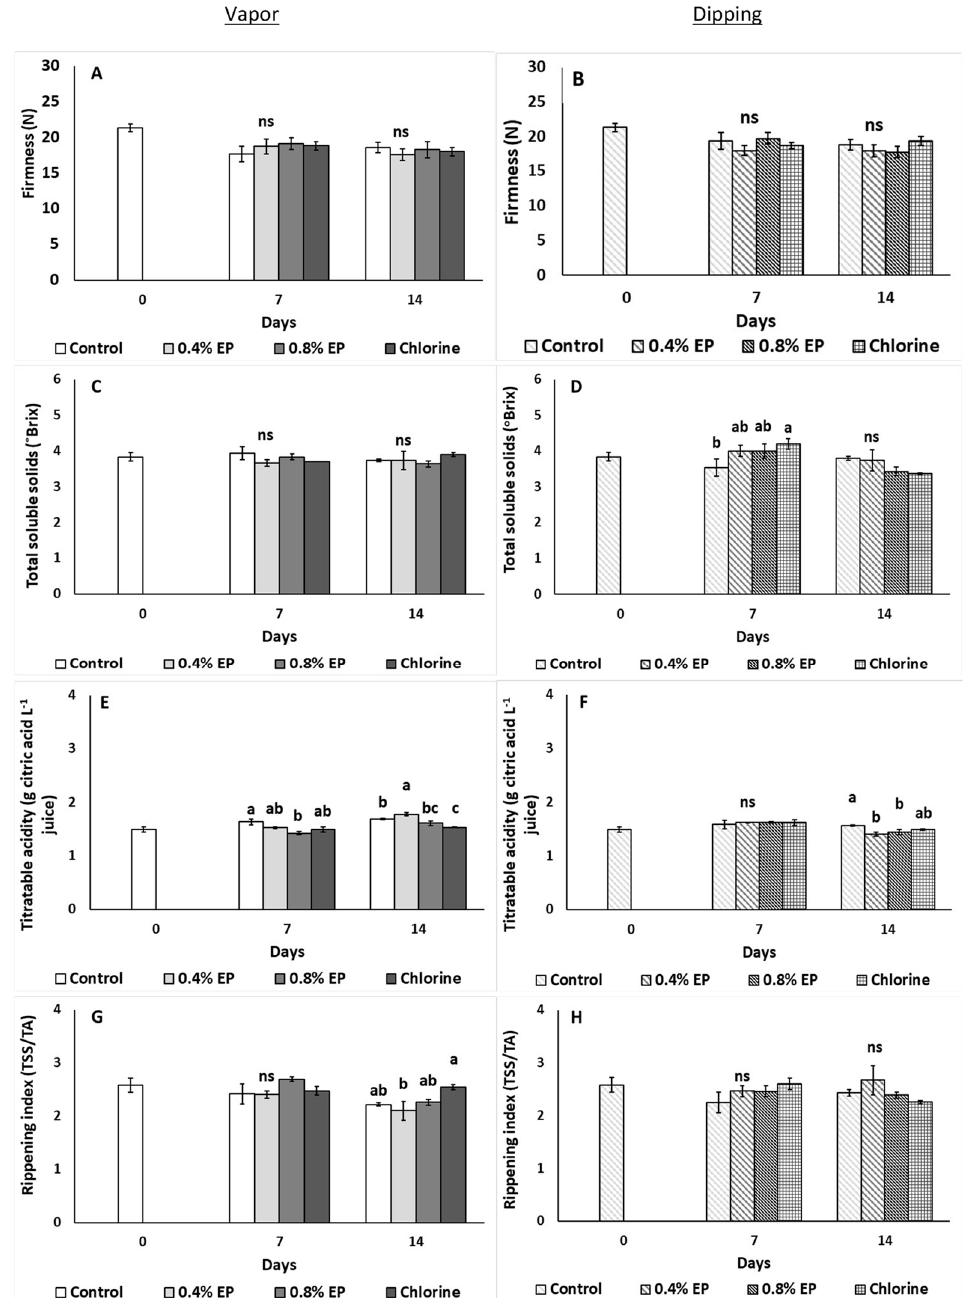
Figure 5. Effects of vapor ( A , C , E , G ) or dipping ( B , D , F , H ) application with eco-product (EP) at different concentration (0–0.4% and 0.8%), chlorine (0.02%) or control (application with water) on firmness (N), total soluble solids (TSS; o Brix), titratable acidity (TA; g citric acid L − 1 juice) and ripening index (TSS/TA) of cucumber fruits stored at 11 ◦ C and RH ~90% up to 14 days. Means ± SE followed by different Latin letters are significantly different according to Duncan’s MRT ( p = 0.05). ns: not